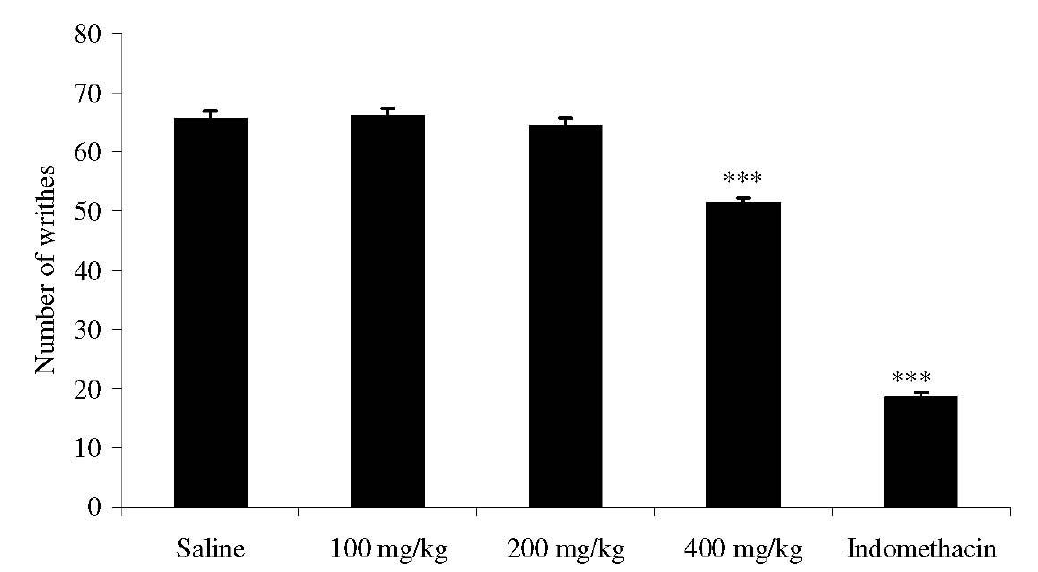
Figure 1. Effects of the ethanol extract from M. platyclada leaves on acetic acid-induced writhing in mice. Data are mean  s.e.m. of eight mice. *** P < 0.001 vs. control